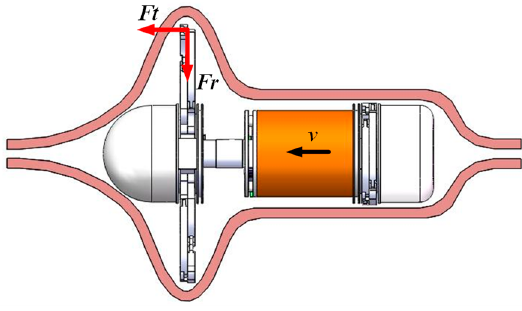
Figure 9. The force condition of GMR in the intestine.